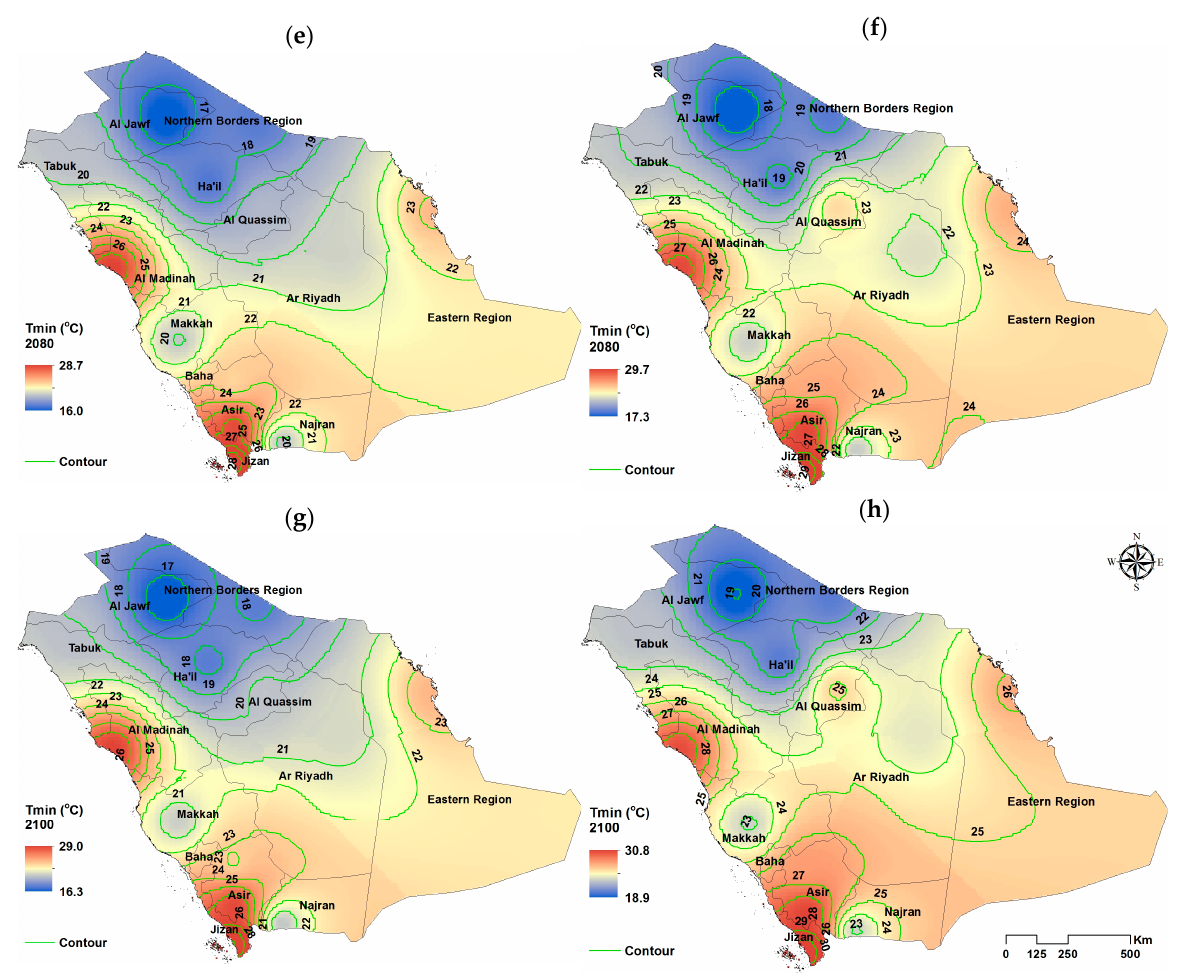
Figure 3. Annual-averaged Tmin (°C) under SSP2-4.5 on the left for ( a ) 2040, ( c ) 2060, ( e ) 2080, and ( g ) 2100 and SSP2-8.5 on the right for ( b ) 2040, ( d ) 2060, ( f ) 2080, and ( h ) 2100.